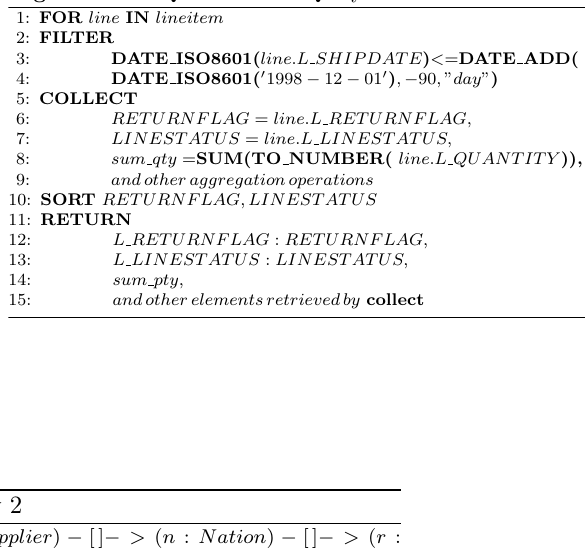
Algorithm 1 AQL for TPC-H Query 1